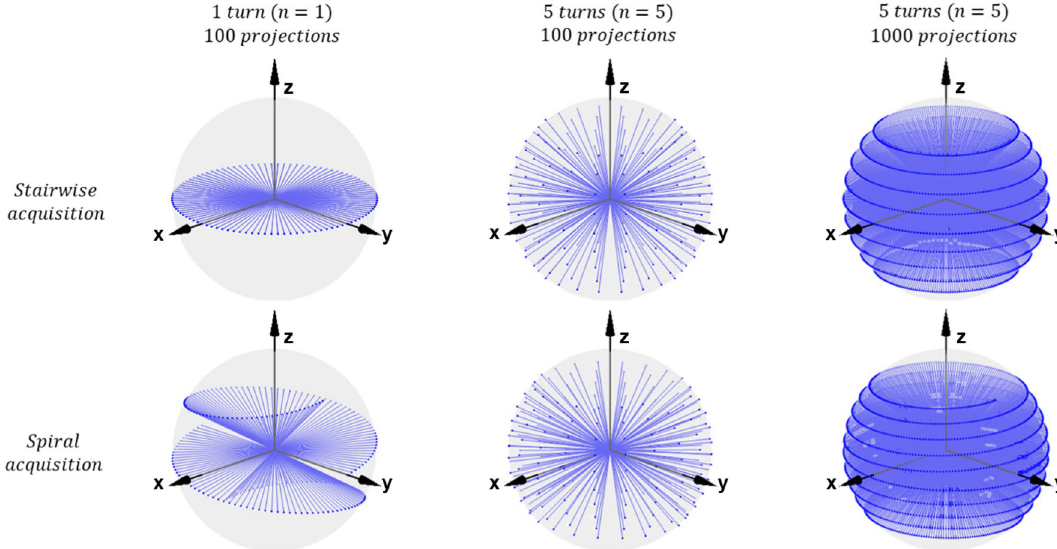
Figure 2. Beam entry/exit trajectories for stairwise and spiral acquisition schemes from the sample’s point of view. The number of turns n and the total number of projections are indicated on top of the plots. The tilt angle β for the shown stairwise trajectory with n = 1 is 0 ◦ but it can be chosen to be any angle between 0 ◦ and 45 ◦